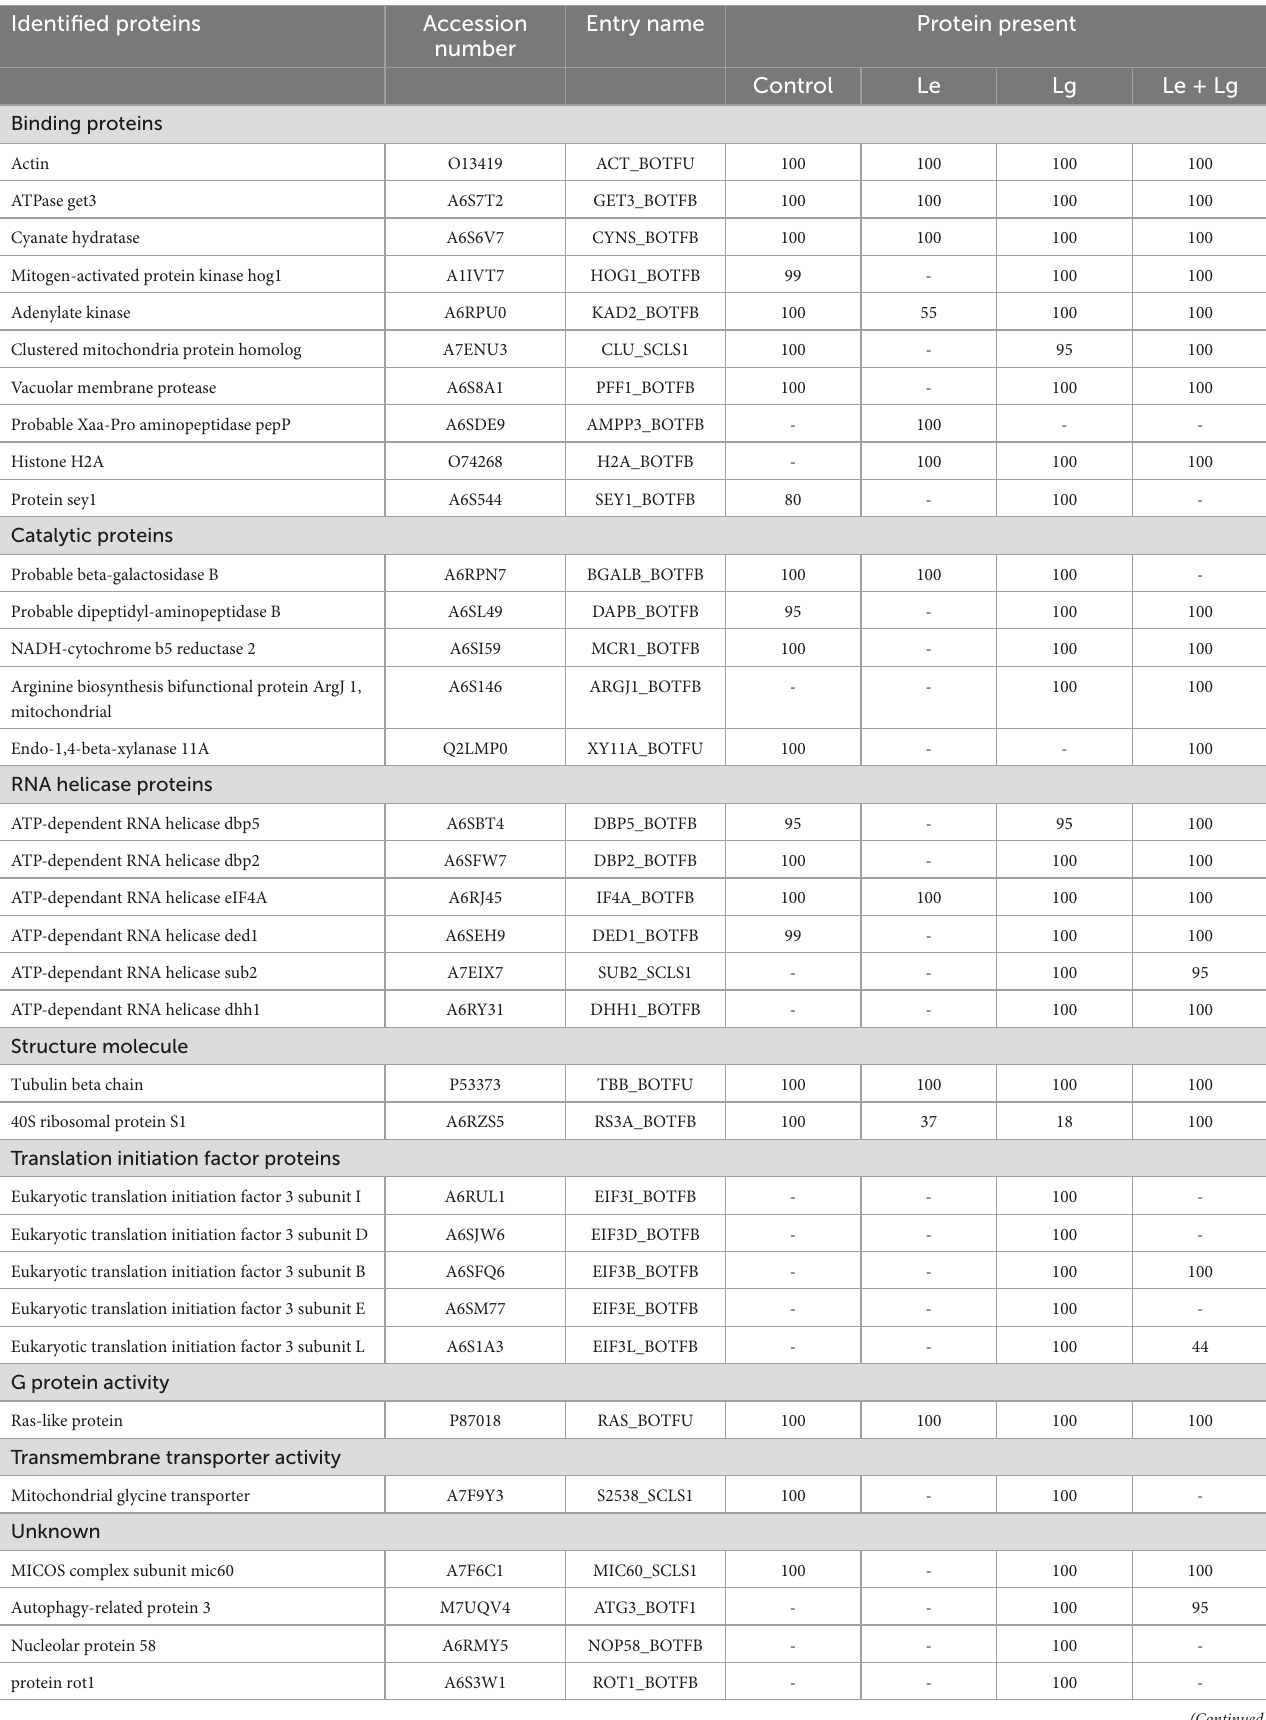
TABLE 2 List of proteins identified in lemon and lemongrass essential oil treated B. cinerea mycelia this study. Identified